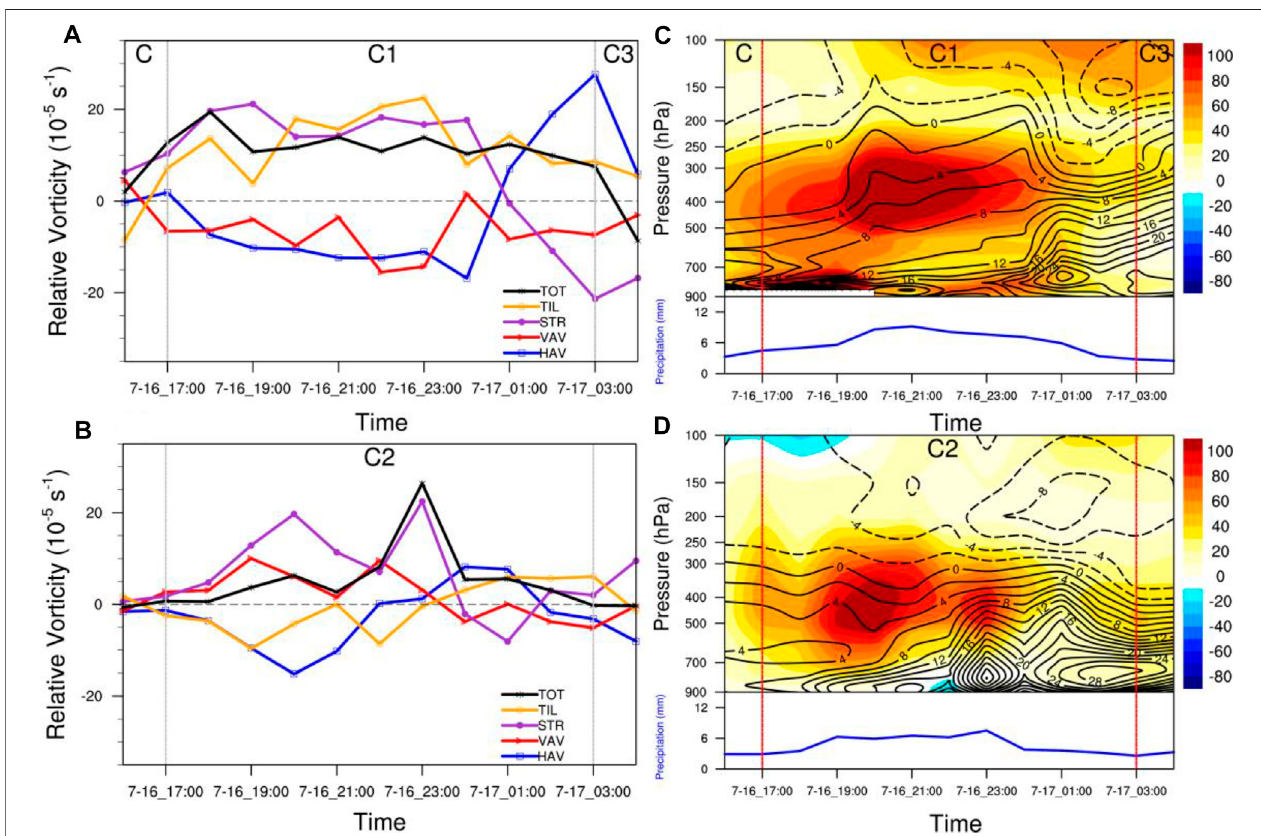
FIGURE 9 | Regionally averaged vorticity budget terms (units: 10 − 9 s − 2 ) for (A) C, C1, C3, and (B) C2 at 700 hPa, and time – pressure sections of apparent heat source Q1 (K day − 1 , shaded), relative vorticity (10 − 5 s − 1 , black contours), and regional mean precipitation over the key region (mm, blue line) from 16:00 UTC July 16 to 04:00 UTC July 17 in the CTL experiment for (C) C, C1, C3, and (D) C2. HAV, VAV, STR and TIL denote horizontal advection of vorticity, vertical advection of vorticity, stretching,and tilting,respectively.ThelocaltimerateofchangeofvorticityisabbreviatedasTOT.Verticalgraysolidlines markthestartandend timeoftheSWVs.